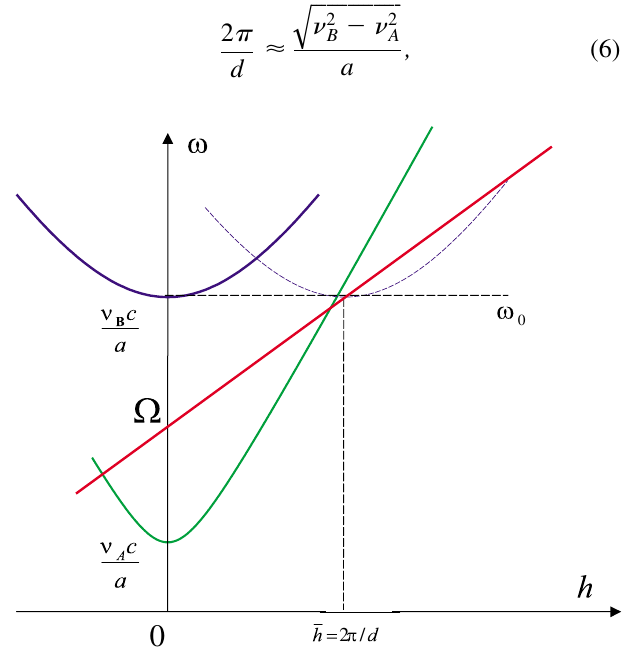
FIG. 2. (Color) Dispersion diagrams, showing the coupling of propagating (green curve) and cutoff (blue curve) partial waves. The red line is an electron wave ! (cid:1) (cid:5) (cid:8) hv jj